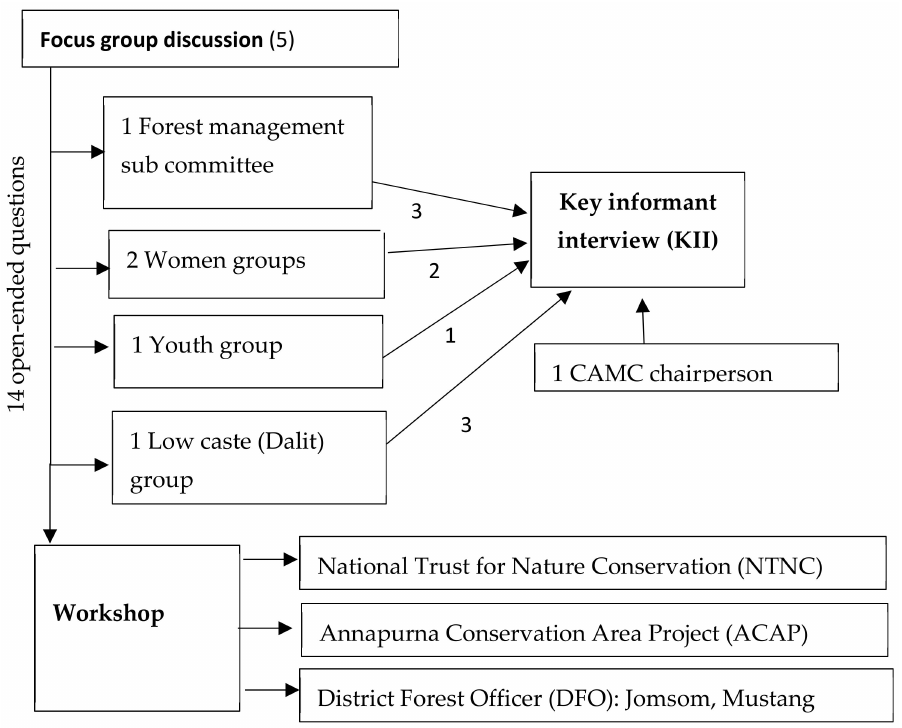
Figure 2. Data collection chart. Note: CAMC = Conservation Area Management